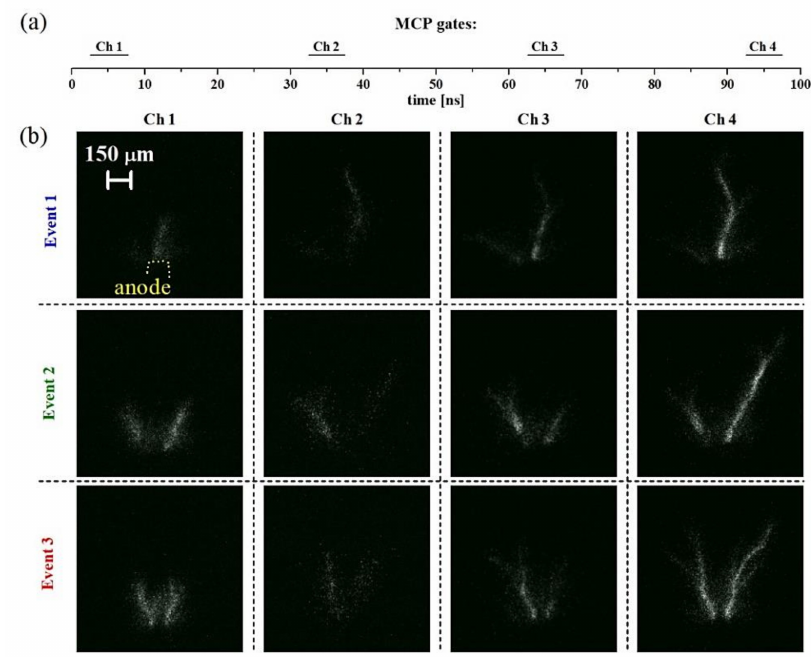
Figure 13. Case study C; image sequences obtained using the discharge emission that passes through the λ c = 656 nm interferential filter. Horizontal bars in ( a ) labelled as Ch1–Ch4 illustrate the timing of the Ch1–Ch4 MCP gates with respect to the onset ( t = 0 ns) of the HV pulse. Images in panel ( b ) show the evolution of selected events during the primary and first three reflected HV pulses acquired by using equal Ch1–Ch4 MCP gates of 5